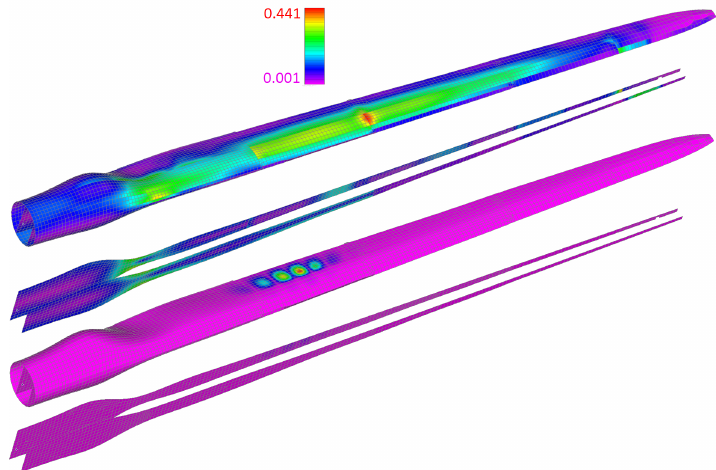
Figure 23. FEA fiber failure index and buckling eigenvector results for MOSOP4 solution extracted.